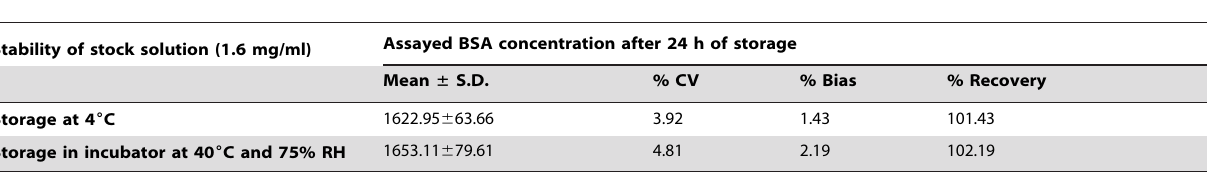
Table 4. Stability of the BSA stock solution, where the BCA method was used for BSA quantification (means 6 S.D., N= 3, 8 replicates for each